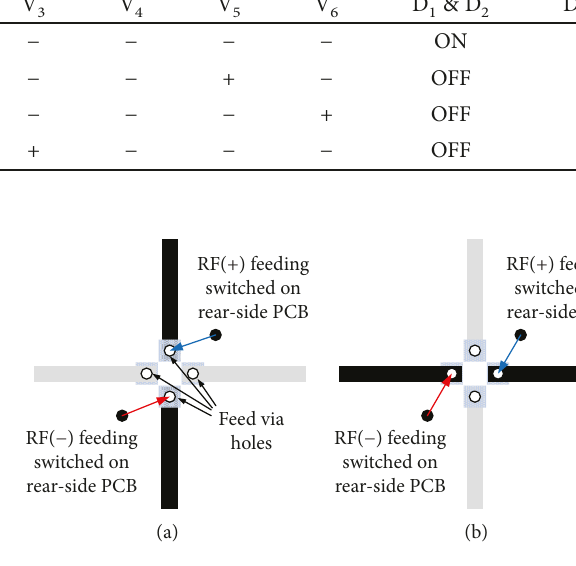
Figure 5: Switching excitations to the crossed active elements: (a) x-axis excitation; (b) y-axis